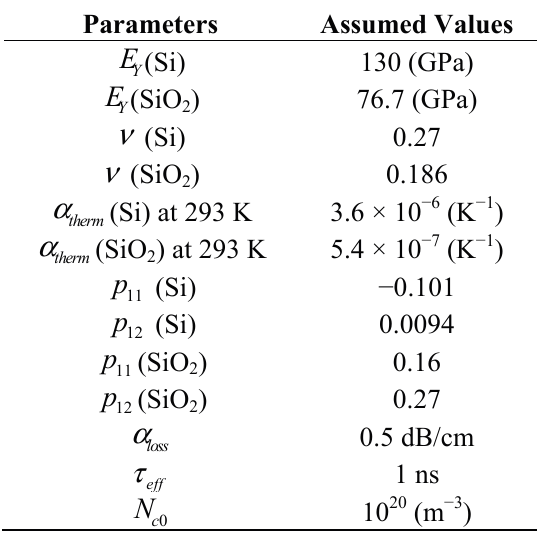
Table 1. Physical parameters used in simulations.